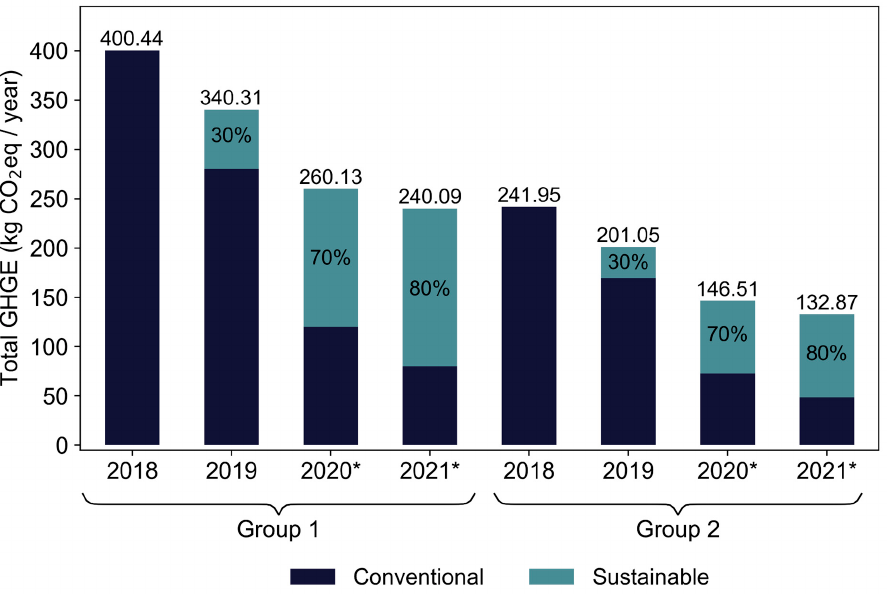
Figure 5. The total GHGE of school menus, including the contribution of sustainable and conventional food menus. The figure compares the estimated GHGE produced per year (in kg CO 2 e), between the two different food menu types targeted in this study. The percentages represent the amount of food menus being sustainable in each year, with 100% equivalent to 5 days a week. * The graph shows the projections for the years 2020 and 2021, following the implementation plan of the SSP; in 2018, there were no sustainable food menus.